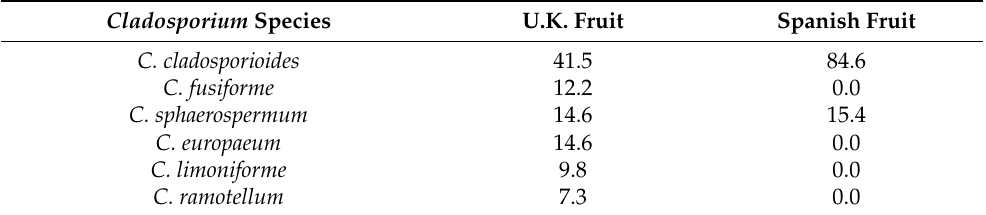
Table 1. The percentage breakdown of Cladosporium species present on raspberries collected from the U.K. and Spain. The total number of isolates was 54, with 41 from the U.K. and 13 from Spain. Cladosporium Species U.K.